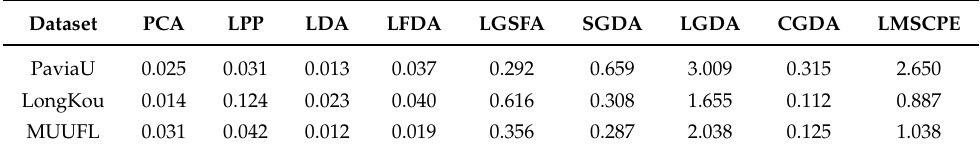
Table 7. Computational time (in seconds) of the different algorithms on the PaviaU, LongKou, and MUUFL data